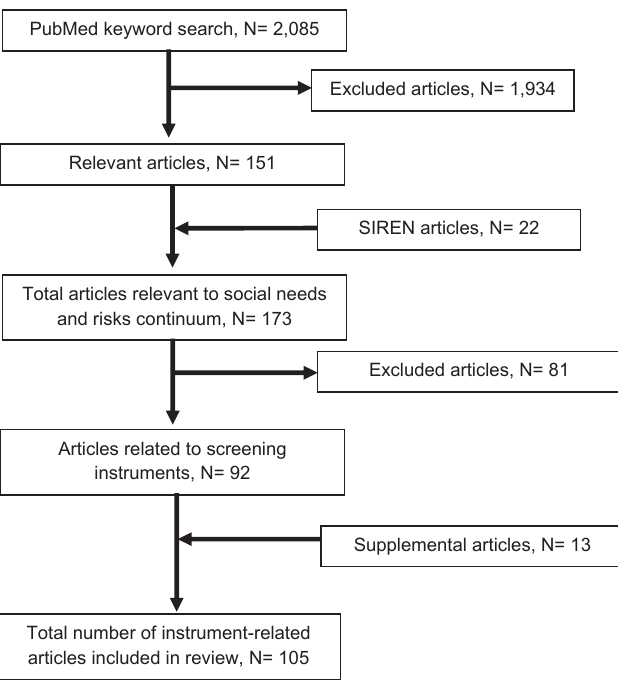
Figure. Flow diagram of literature review search